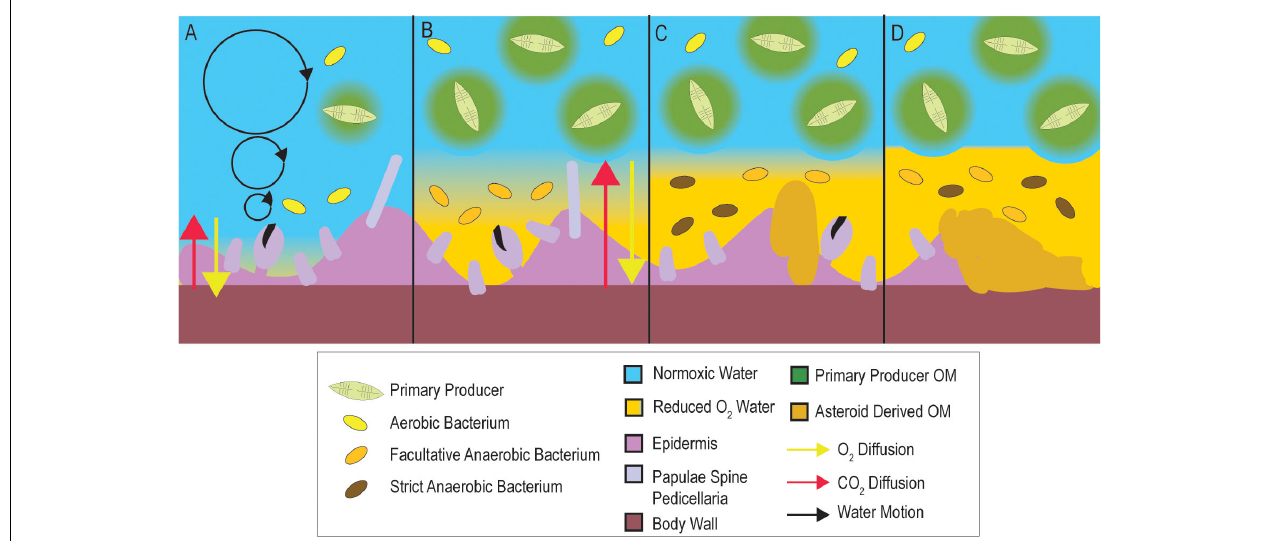
FIGURE 1 | Conceptualization of how microbial activities in the DBL may precipitate SSW. Under typical conditions (A) , DBL conditions are normoxic. When OM increases in overlying waters ( B ; e.g., during elevated primary productivity, from terrestrial runoff, or from decaying asteroid carcasses), microbial heterotrophic respiration and cell abundance are stimulated, which may result in the formation of depleted O 2 within the DBL. This in turn results in longer distances over which diffusion must occur to maintain animal respiratory demand. Over time (C) depleted O 2 conditions in the DBL results in tissue damage, and prevalence of strict and facultative anaerobes. Because their growth is less efficient than aerobic metabolisms their abundance is less than at onset of depleted O 2 conditions. Release of labile OM from decaying tissues (D) and persistent OM-rich conditions within the asteroid DBL result in animal